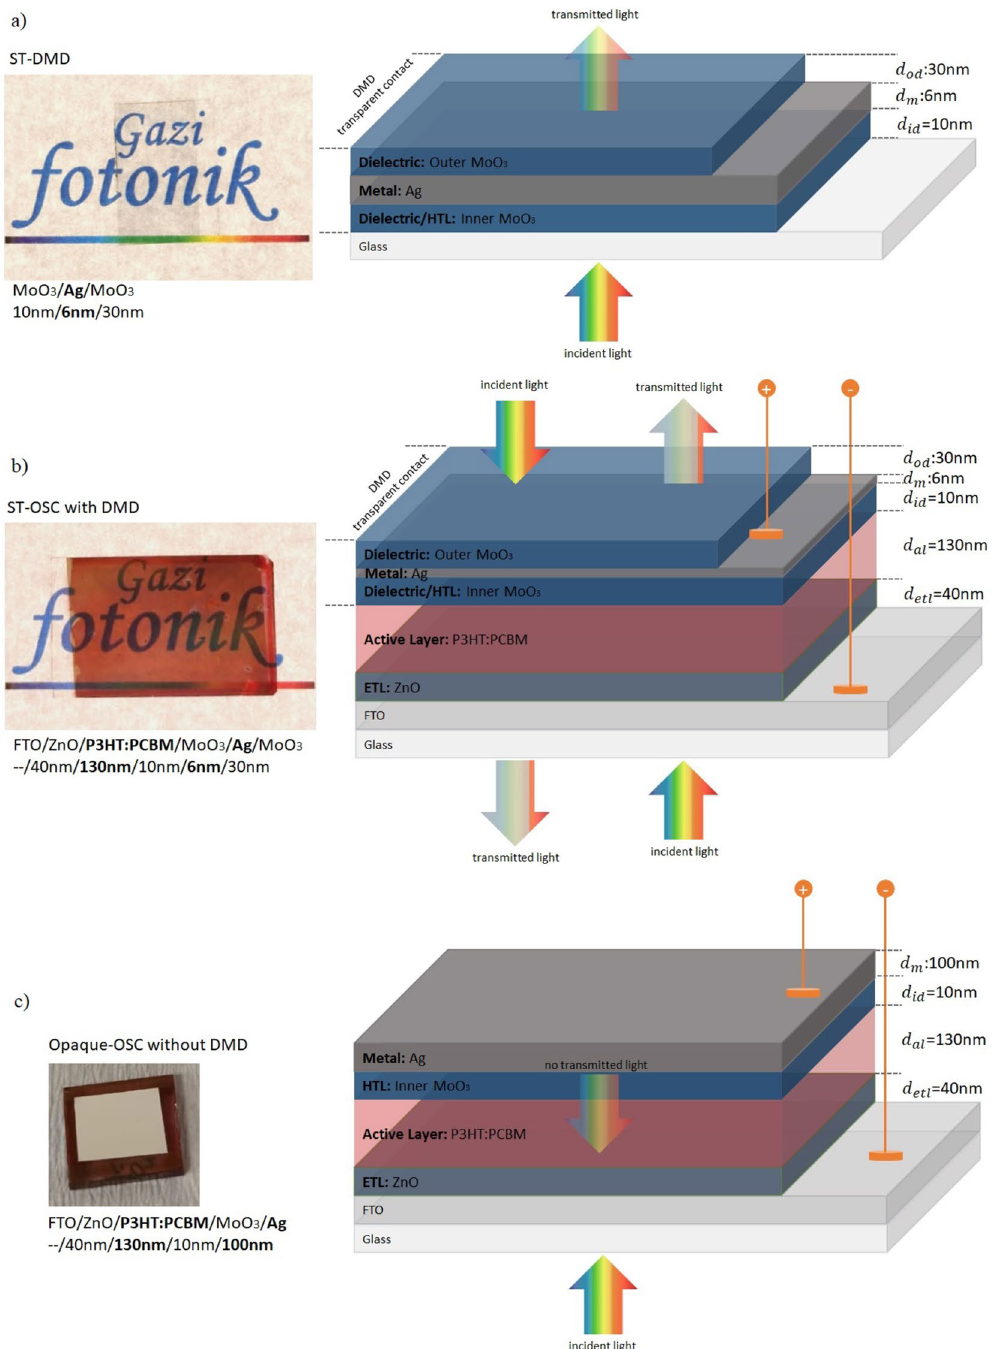
Figure 10. The photo and structure of; ( a ) the MoO 3 /Ag/MoO 3 (10/6/30 nm) transparent top contact, ( b ) FTO/